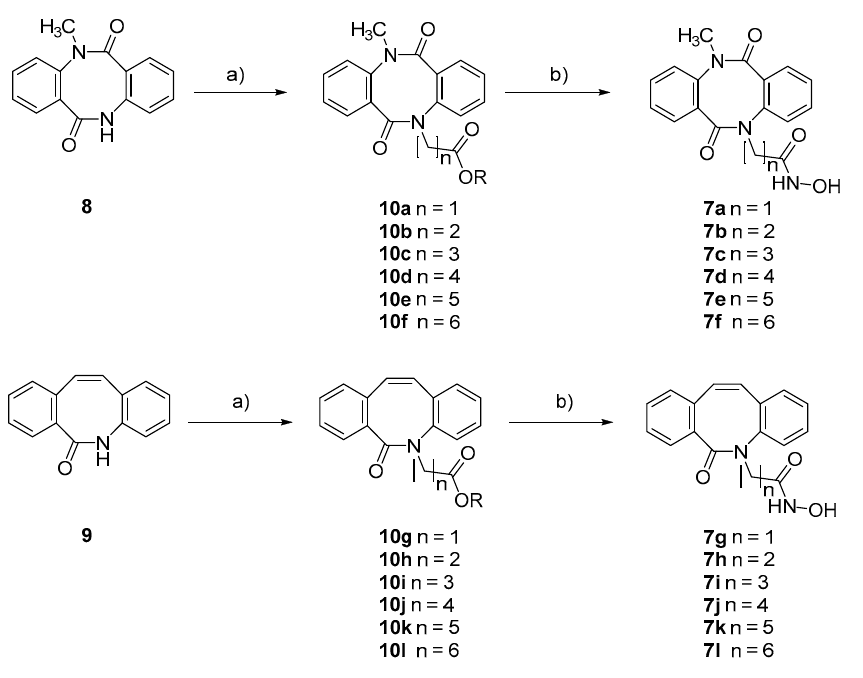
Figure 2. ConceptofresearchanddevelopmentofnoveltricyclicanaloguesofHDACinhibitor, Figure 2. Concept of research and development of novel tricyclic analogues of HDAC inhibitor, Vorinostat.